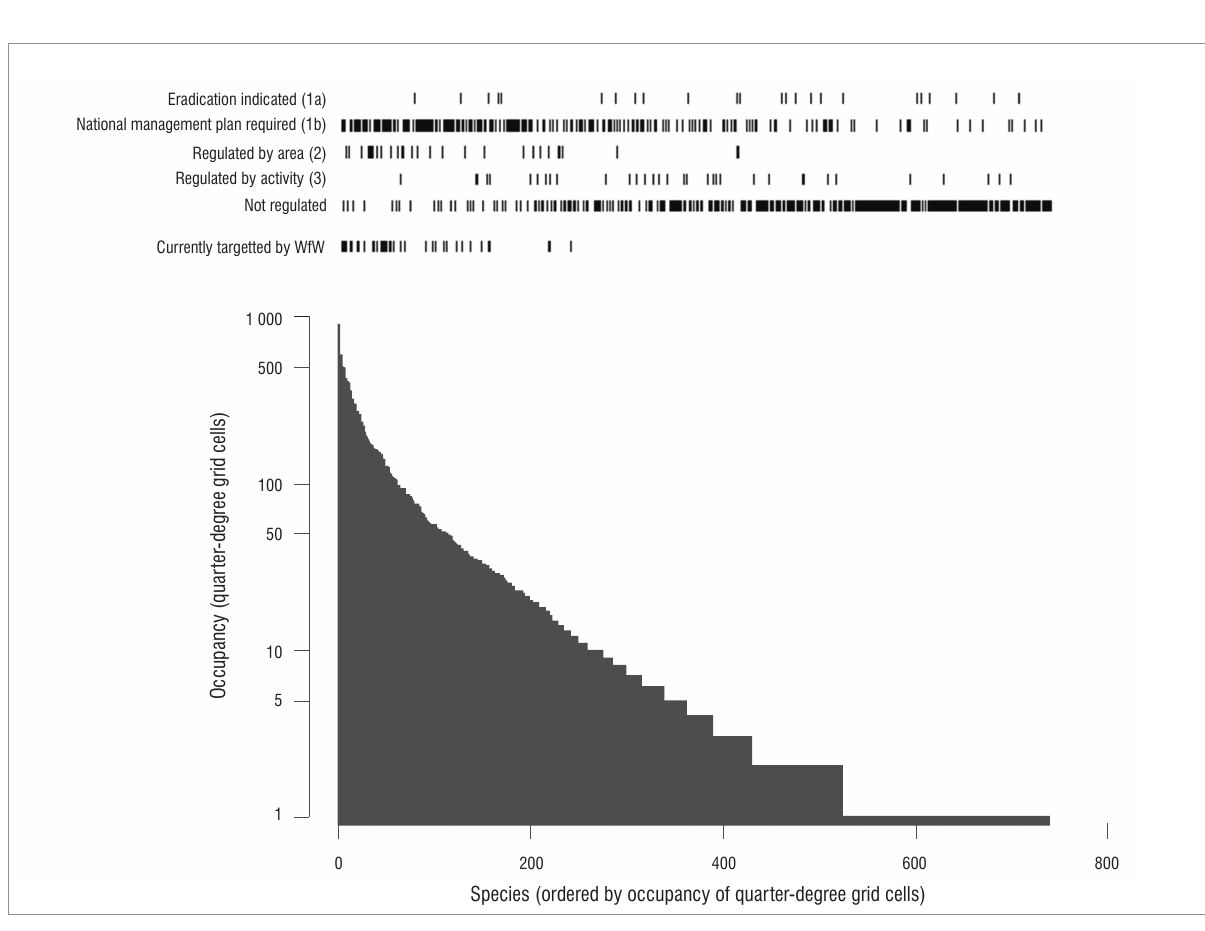
Figure 2: The different legislative categories and the management targets for the Working for Water (WfW) Programme correspond poorly to estimates of the extent of invasions. Specifically some species are found at many sites, but are indicated for eradication (1a species to the left of the graph); other prohibited species are only recorded in one area, but eradication is not considered (1b species to the right of the graph); and some species are widespread invaders that are not regulated at all (species to the left of the graph). Occupancy is based on the Southern African Plant Invader Atlas database 16 (accessed August 2010, 2 years after the programme was started) restricted to records from South Africa and records where the species identity was known. The legislative categories shown are as per the National Environmental Management: Biodiversity Act (10/2004): Draft Alien and Invasive Species Regulations 2009.